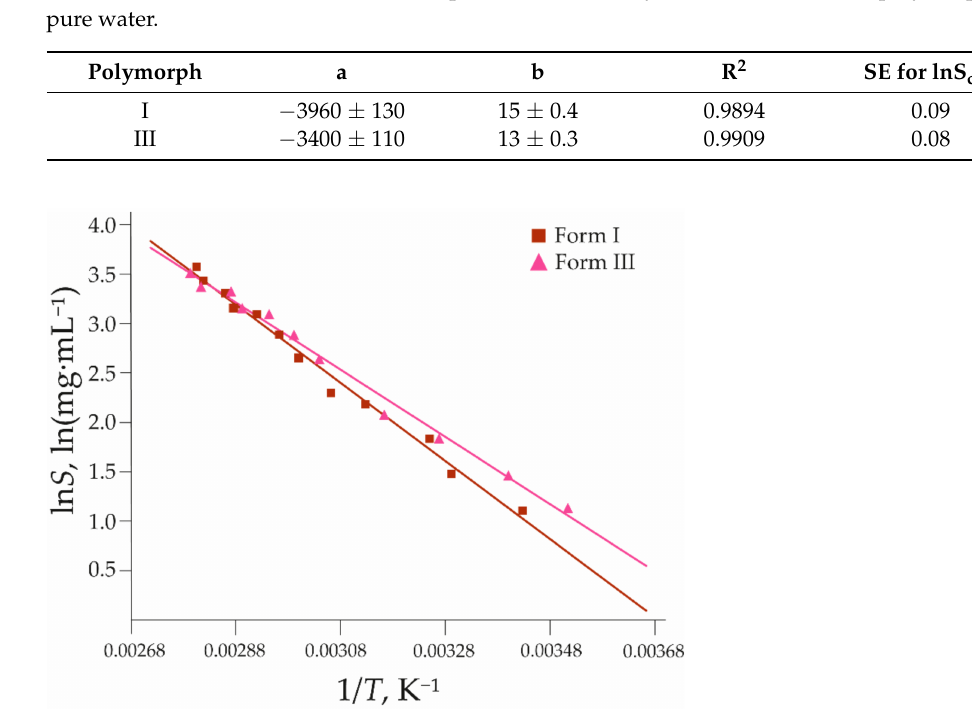
Figure 4. The solubility of 2,6MeOBA polymorphs I and III. Squares and triangles represent ex- perimental data (see Supplementary Materials Tables S2 and S3), while lines are calculated using Equation (1) with coefficients a and b found in the fitting using the least-squares approach, given in Table